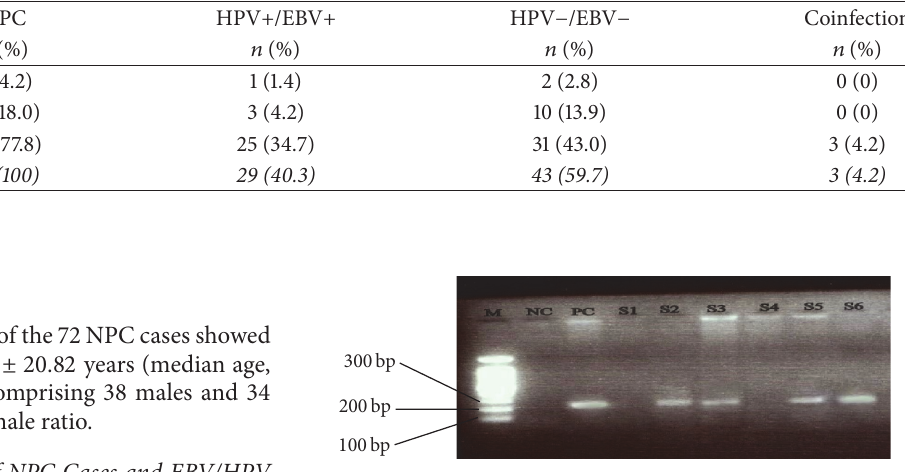
Figure 1: An electropherogram of Epstein-Barr virus PCR ampli- cons. The 229 bp fragment corresponds to the amplified EBV DNA. Lane M: 100 bp molecular size marker; NC: negative control (no DNA); PC: positive control; S2, S3, S5, and S6: EBV DNA positive samples; S1 and S4: EBV DNA negative